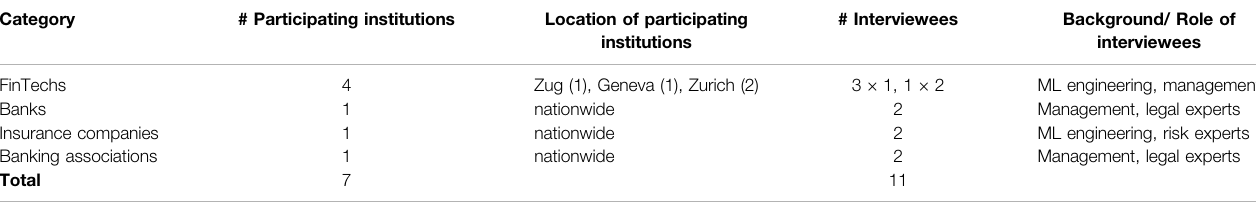
TABLE 1 | Composition of the interviewees participating in the seven semi-structured